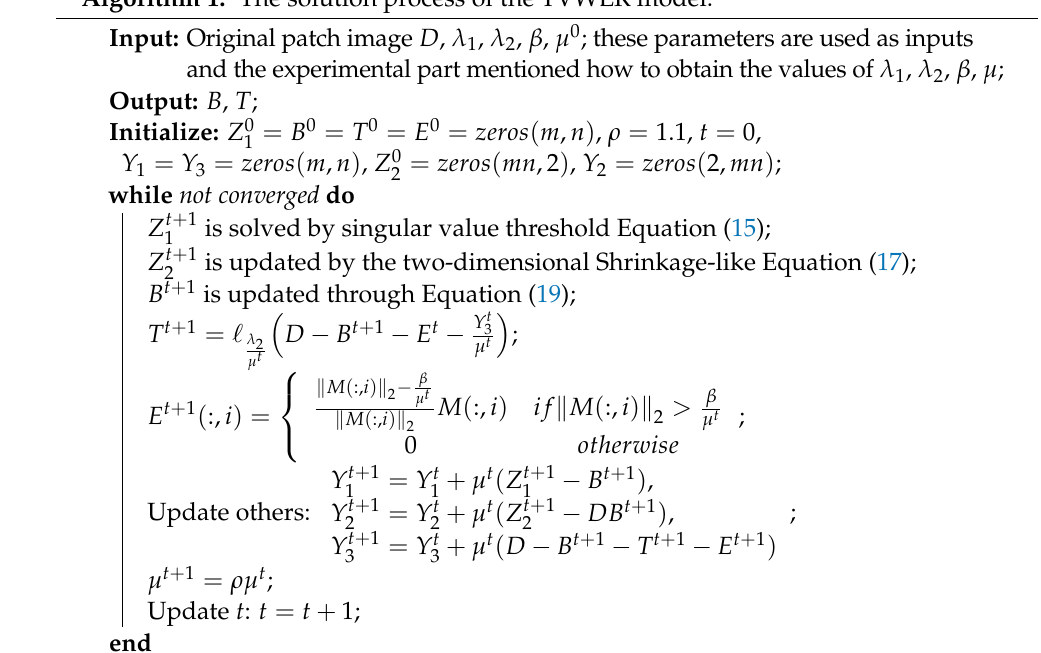
Algorithm 1: The solution process of the TVWLR